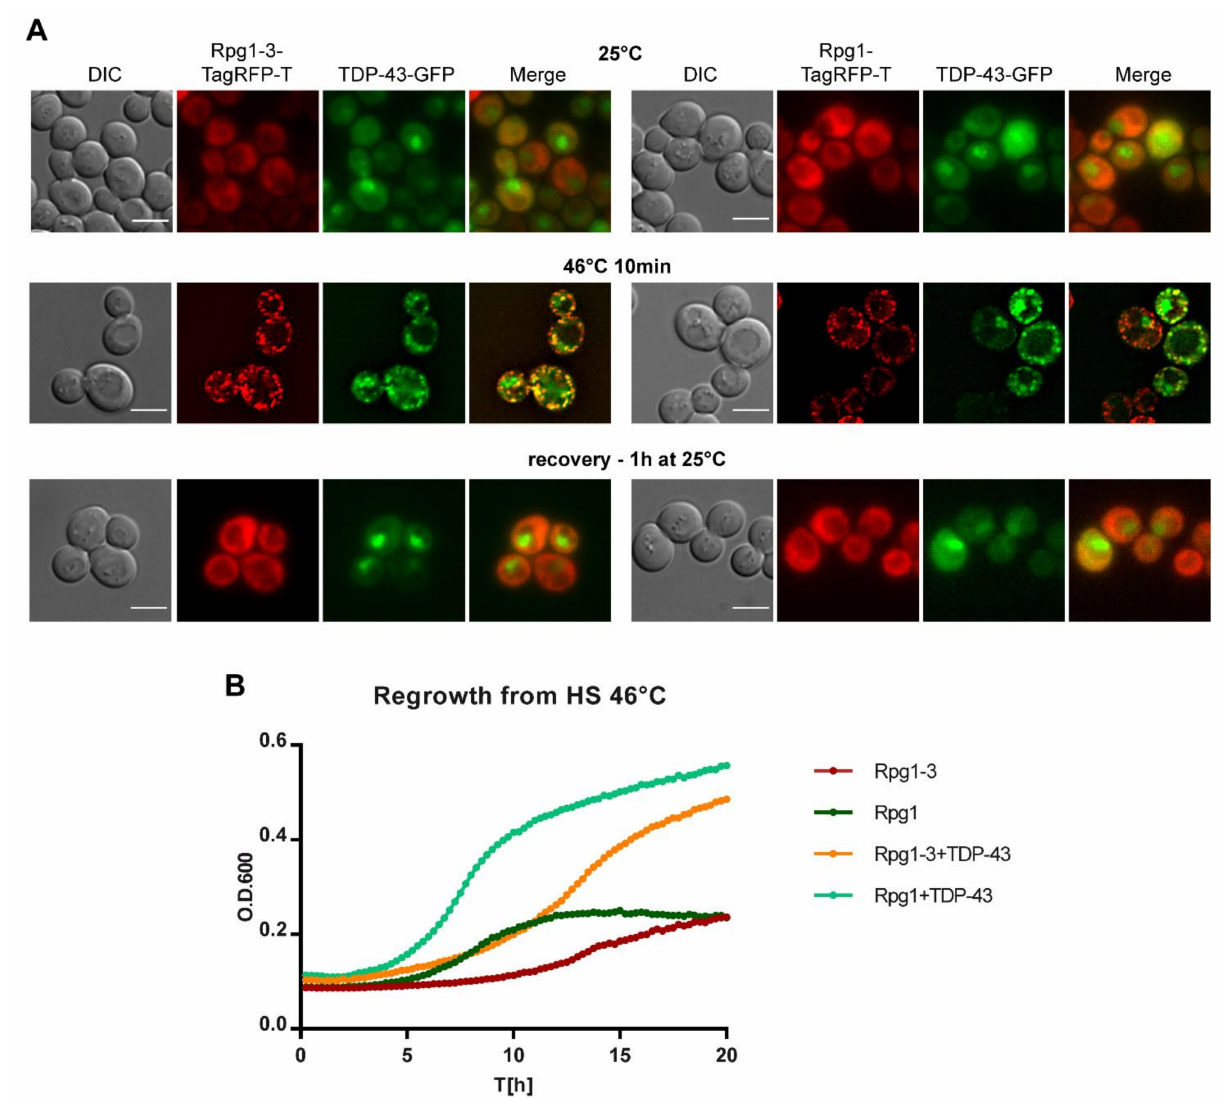
Figure 8. Cellular distribution of TDP-43-GFP in cells producing Rpg1-3-TagRFP-T and Rpg1-TagRFP-T. ( A ) Unstressed exponentially growing cells at 25 ◦ C, after HS for 10 min at 46 ◦ C and after the recovery at 25 ◦ C for one hour. Single layers of Z-stacks are shown. Images after HS were deconvolved with the AMLE filter (Olympus). Scale bars, 5 µ m. ( B ) Regrowth from HS at 46 ◦ C in the glucose-based selective medium at 25 ◦ C. A representative plot from three experiments with the same outcome is